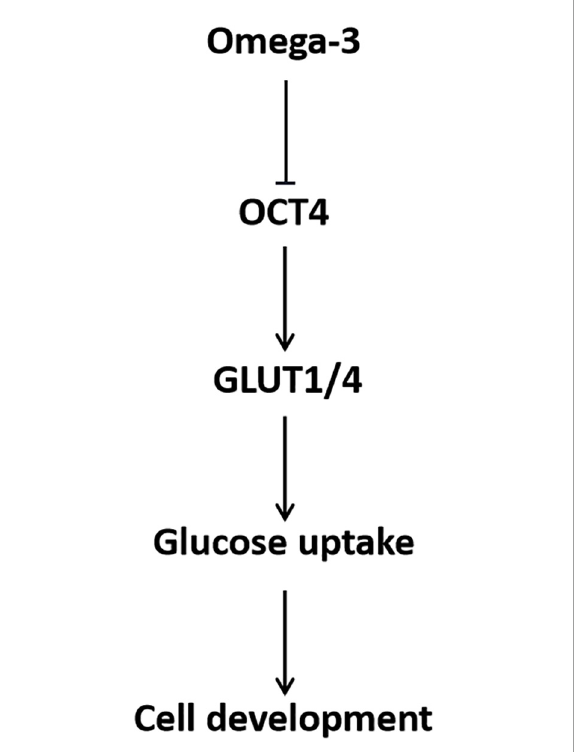
FIGURE7 Schematic of the role of OCT4 in omega-3 inhibited cellular glucose uptake and development in KGN cells.